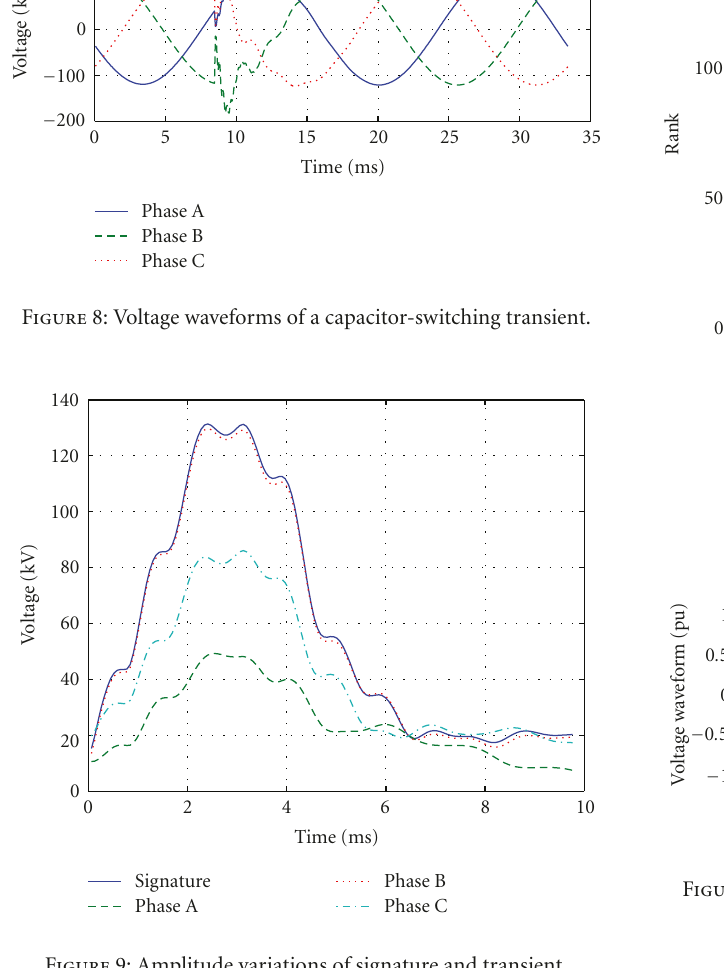
Figure 9: Amplitude variations of signature and transient.